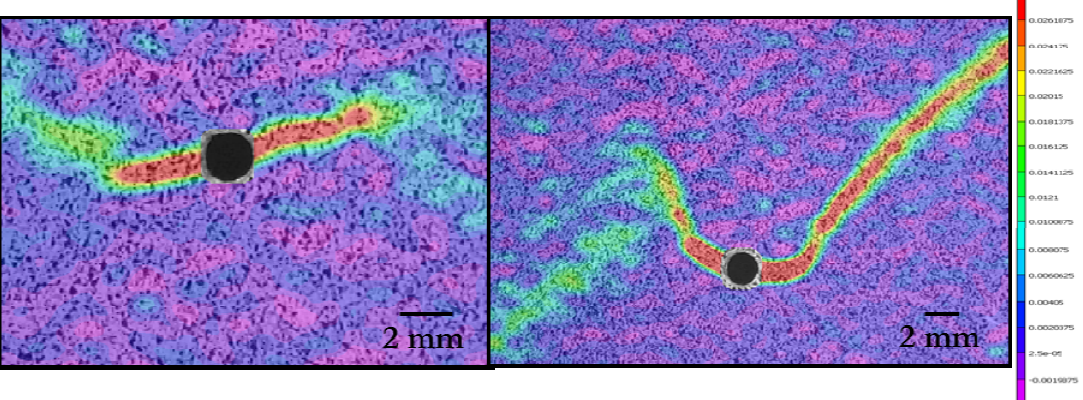
Figure 7: Deformation area as a result of crack growth for cracks growing in microstructures of 0.07 and 8.22 mm. Both pictures show the strain state (calculated on the loading direction,  yy ) of the sample at the moment of the initiation of plastic collapse. It is possible to observe the effect of the grain size on the deformation area, as a result of crack growth. In the case of tests conducted with small microstructures, symmetrical deformation bands are observed on both sides of the notch. While increasing the grain size, the deformation bands are influenced by the microstructure.